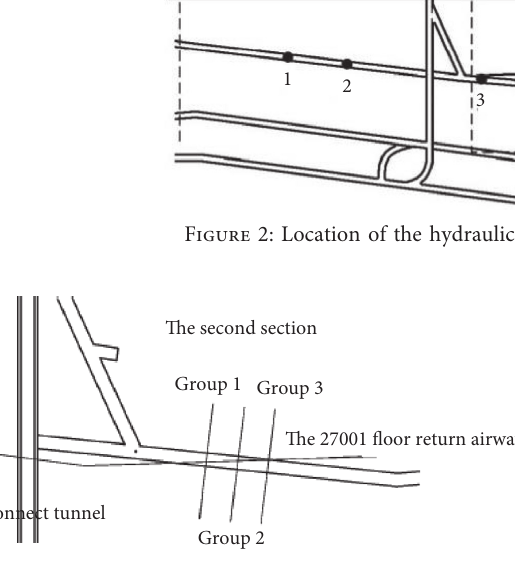
Figure 3: Investigation hole location for the effective extraction radius of hydraulic punching.